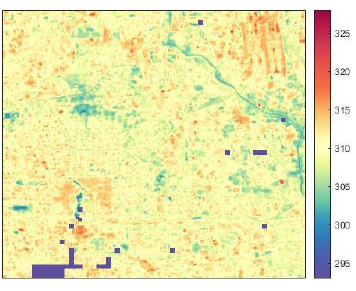
Figure 6. LST Prediction for 08/17/19